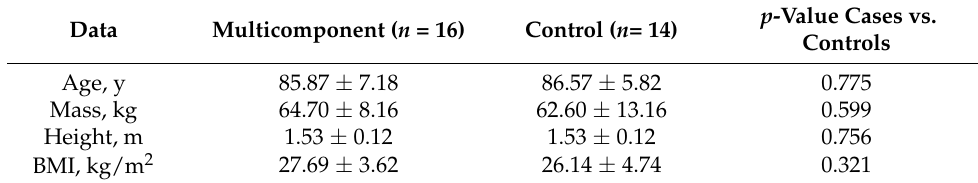
Table 1. Sociodemographic data of the sample.